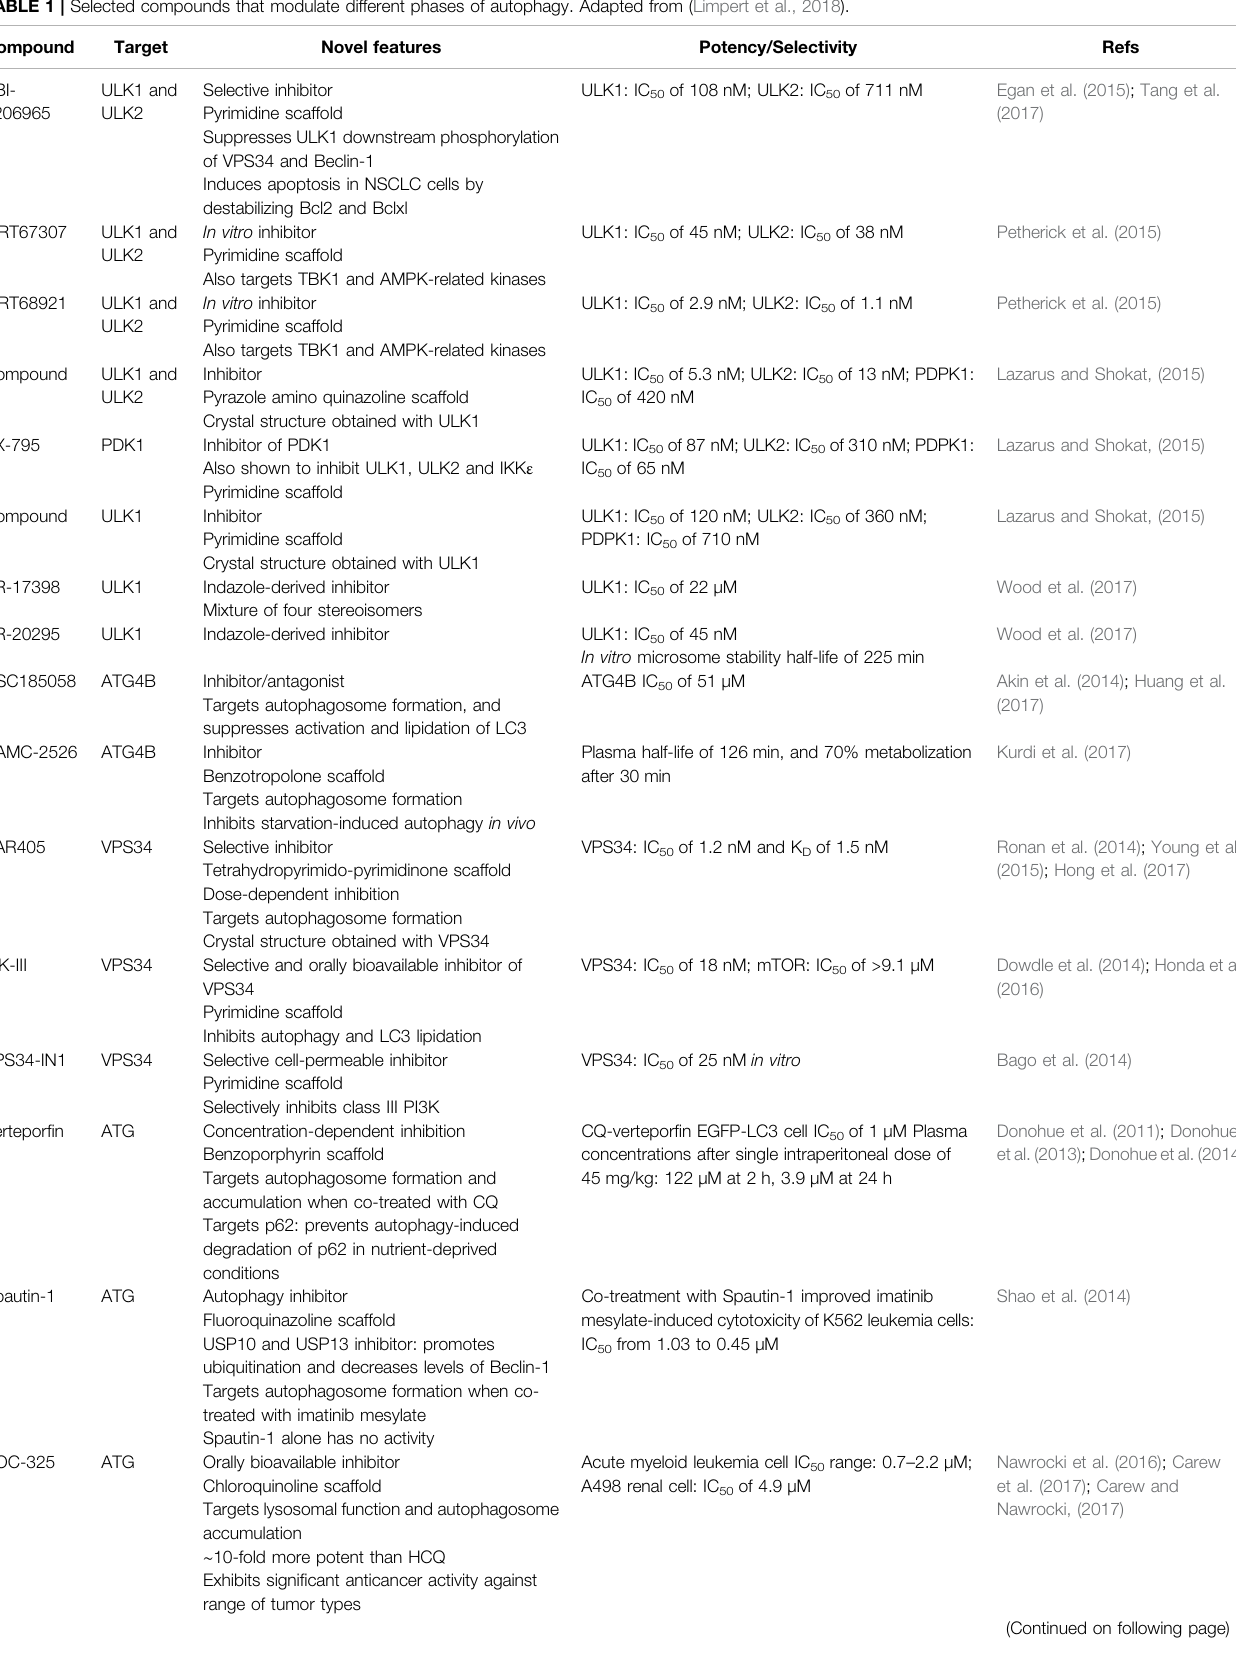
TABLE 1 | Selected compounds that modulate different phases of autophagy. Adapted from (Limpert et al., 2018).